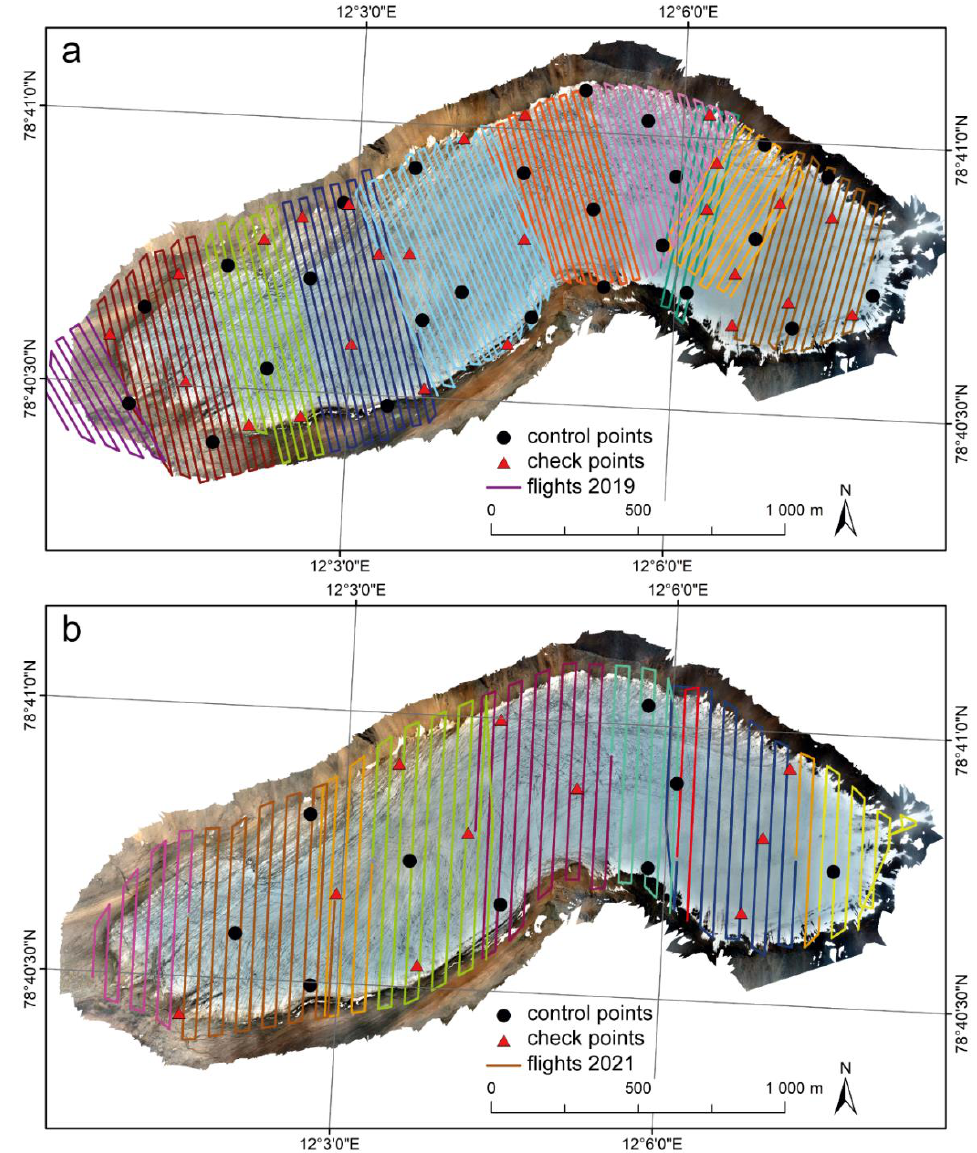
Figure 2. UAV flight coverage areas on orthomosaic of Waldemarbreen. ( a ) In August 2019; ( b ) In August 2021. Each flight is shown in a different color. The red triangles and black circles indicate the checkpoints and control points respectively. Note that the number of GCPs in 2021 is more than two times less than in 2019 due to the usage of the RTK UAV platform.